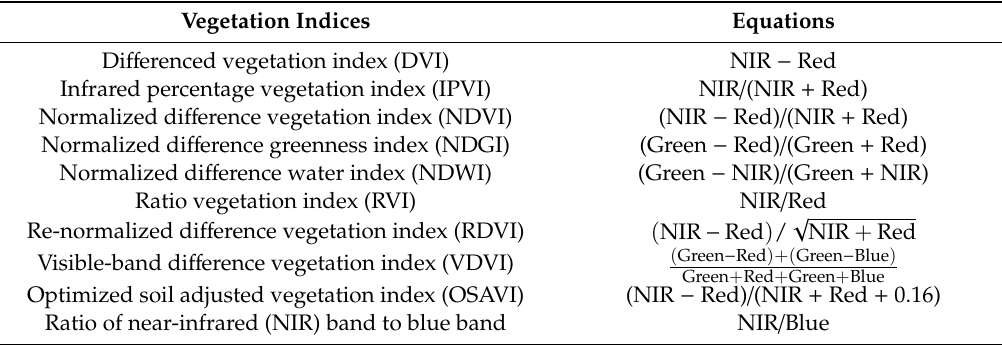
Table 2. Vegetation indices used in the